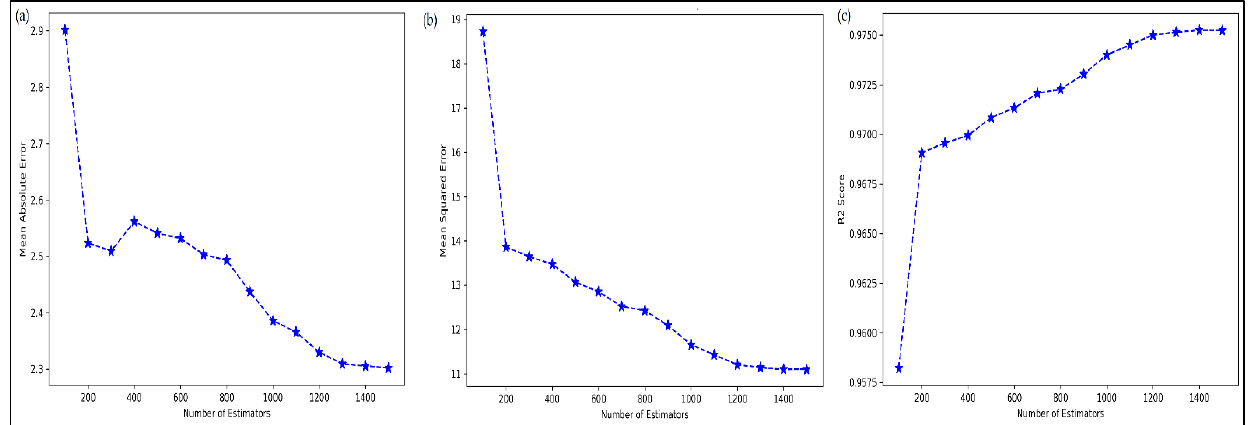
Figure 6. Effect of number of estimators on gradient boosting regression’s performance in terms of ( a ) MAE, ( b ) MSE and ( c ) R 2